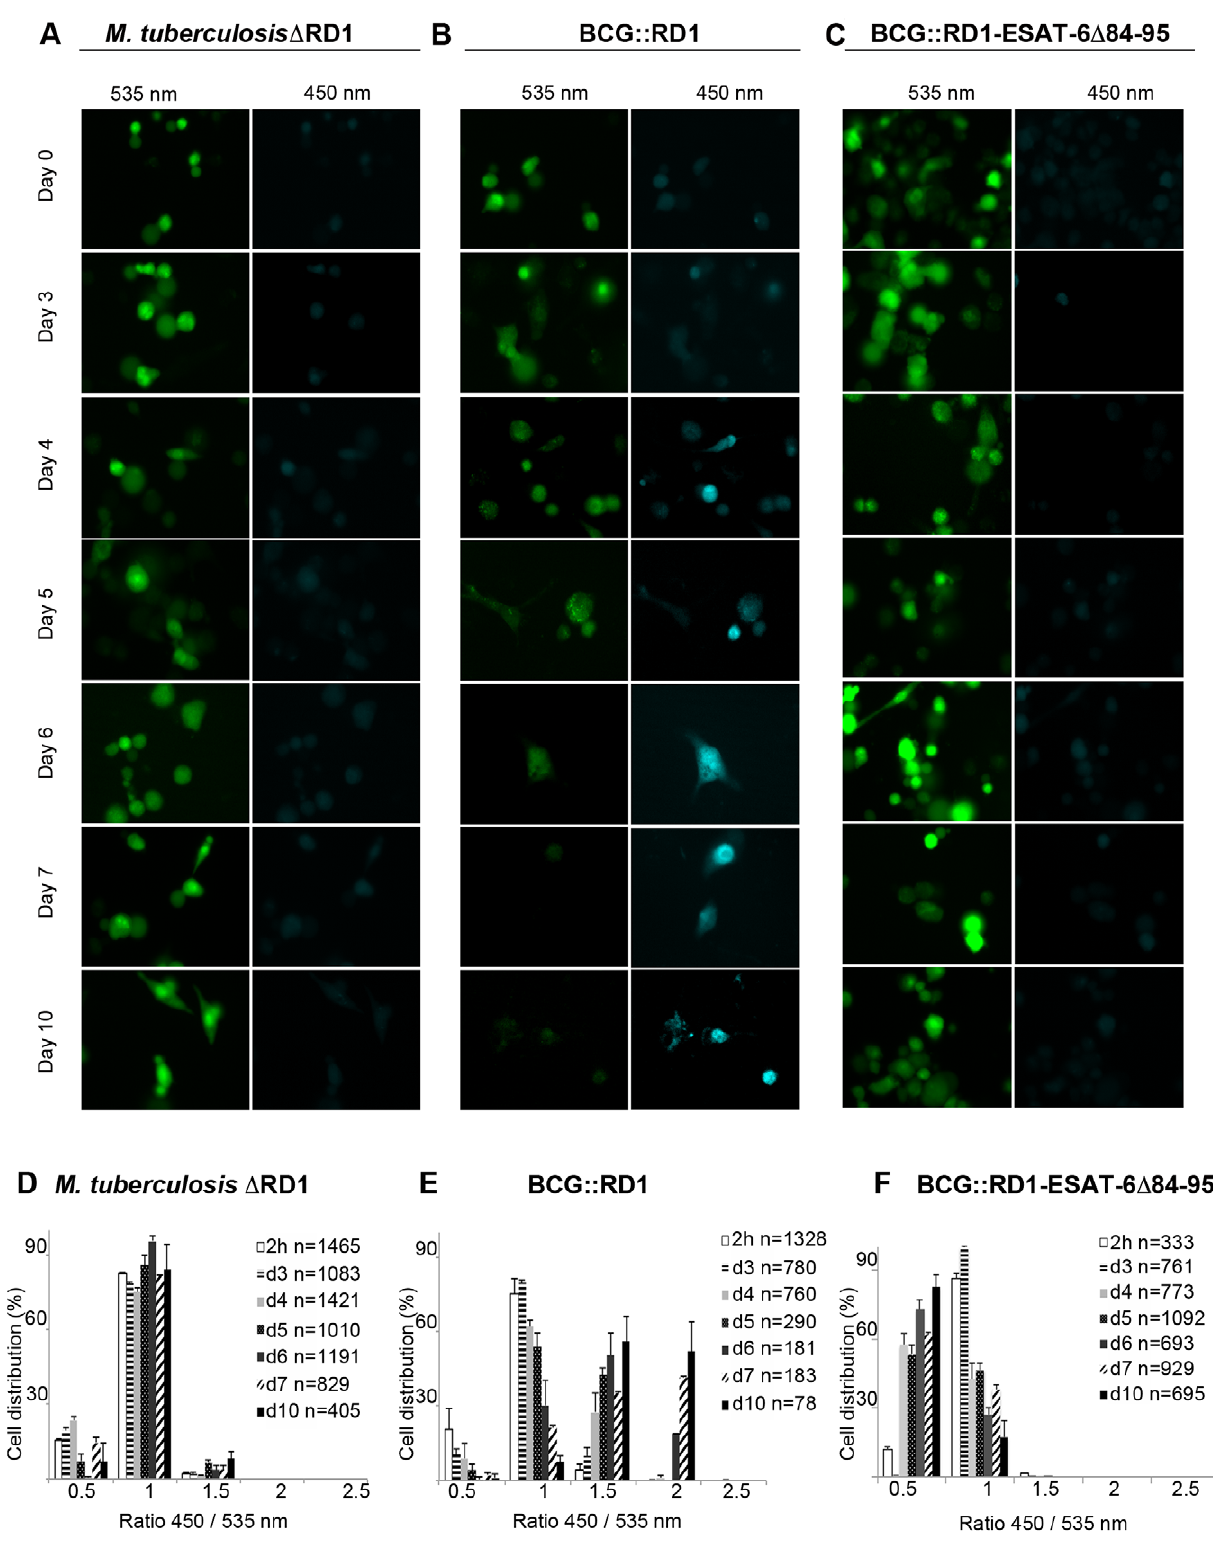
Figure 3. Analysis of ESX-1 deletion-, truncation- and complementation-mutants highlights the link between phagosomal rupture and functional ESX-1 secretion. THP-1 cells were infected with M. tuberculosis D RD1 (A,D), BCG::RD1 (B,E) or BCG::RD1-ESAT-6 D 84–95 (C,F) at a MOI of 1 for the indicated time and then loaded with CCF-4 molecule for 2 h. After PFA fixation, cells were imaged using a fluorescence widefield microscope (Nikon Ti) equipped with a 40X objective (A,B,C). Picture acquisition was achieved randomly and automatically for each condition on 49 fields in duplicates and further 450/535 nm intensity ratio measurement (D,E,F) was obtained through analysis by a specialized algorithm using the Metamorph software. The plots are representative of 3 independent experiments. doi:10.1371/journal.ppat.1002507.g003 PLoS Pathogens |